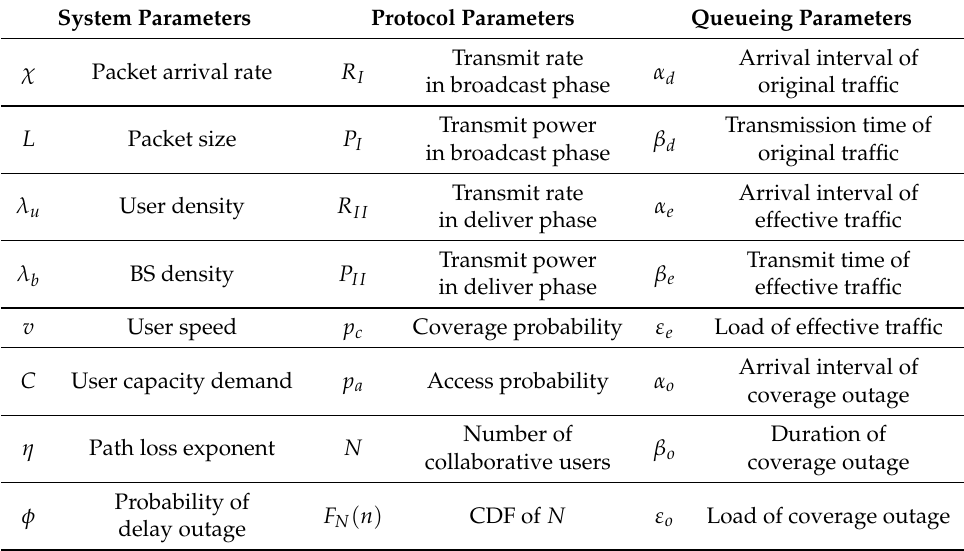
Table 1. List of the main